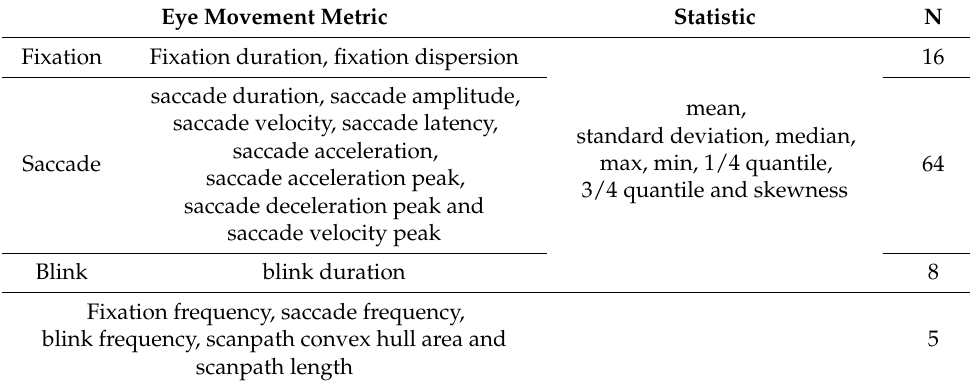
Table 3. Basic statistical features.